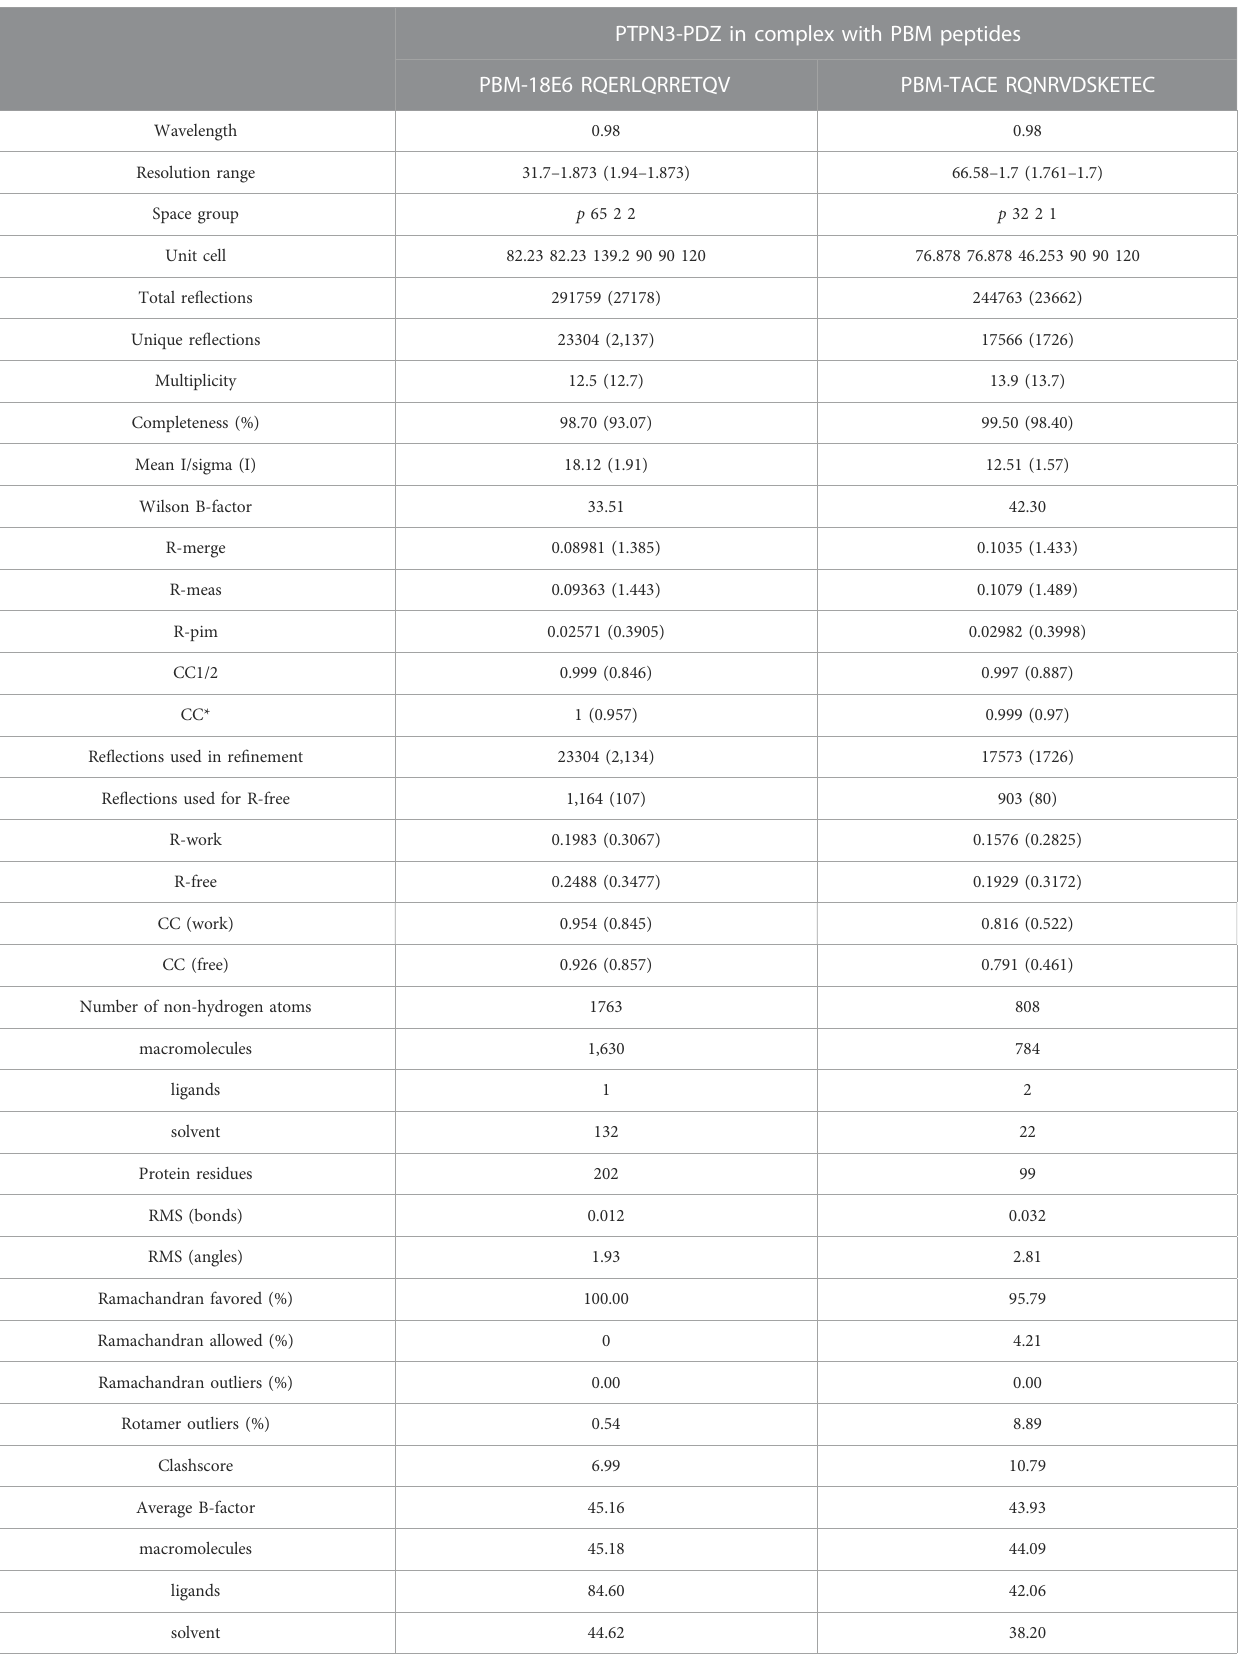
TABLE 2 Data collection and re fi nement